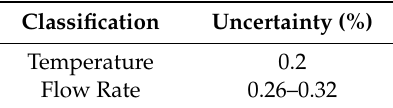
Table 3. Measurement